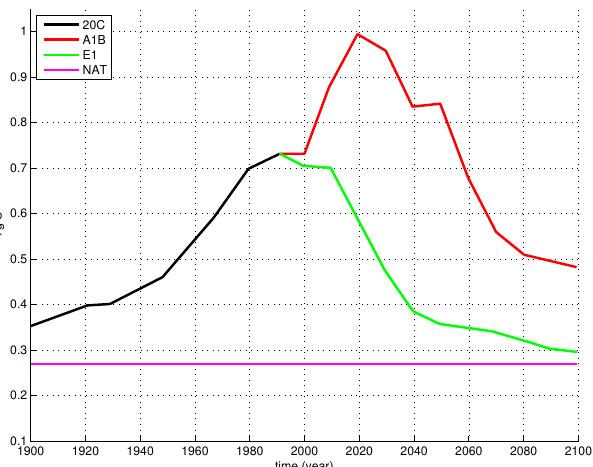
Fig. 2. Evolution of the prescribed total (anthropogenic+natural) sulfate aerosol burden (TgS of total sulfate aerosol) for the observed historical period 1900–2000 (20C; black curve) and the two future scenarios. A1B (red) is the IPCC SRES marker scenario. E1 (green) is the mitigation scenario produced by the IMAGE integrated assessment model. Magenta line also reports constant natural contribution to sulfate aerosol burden.